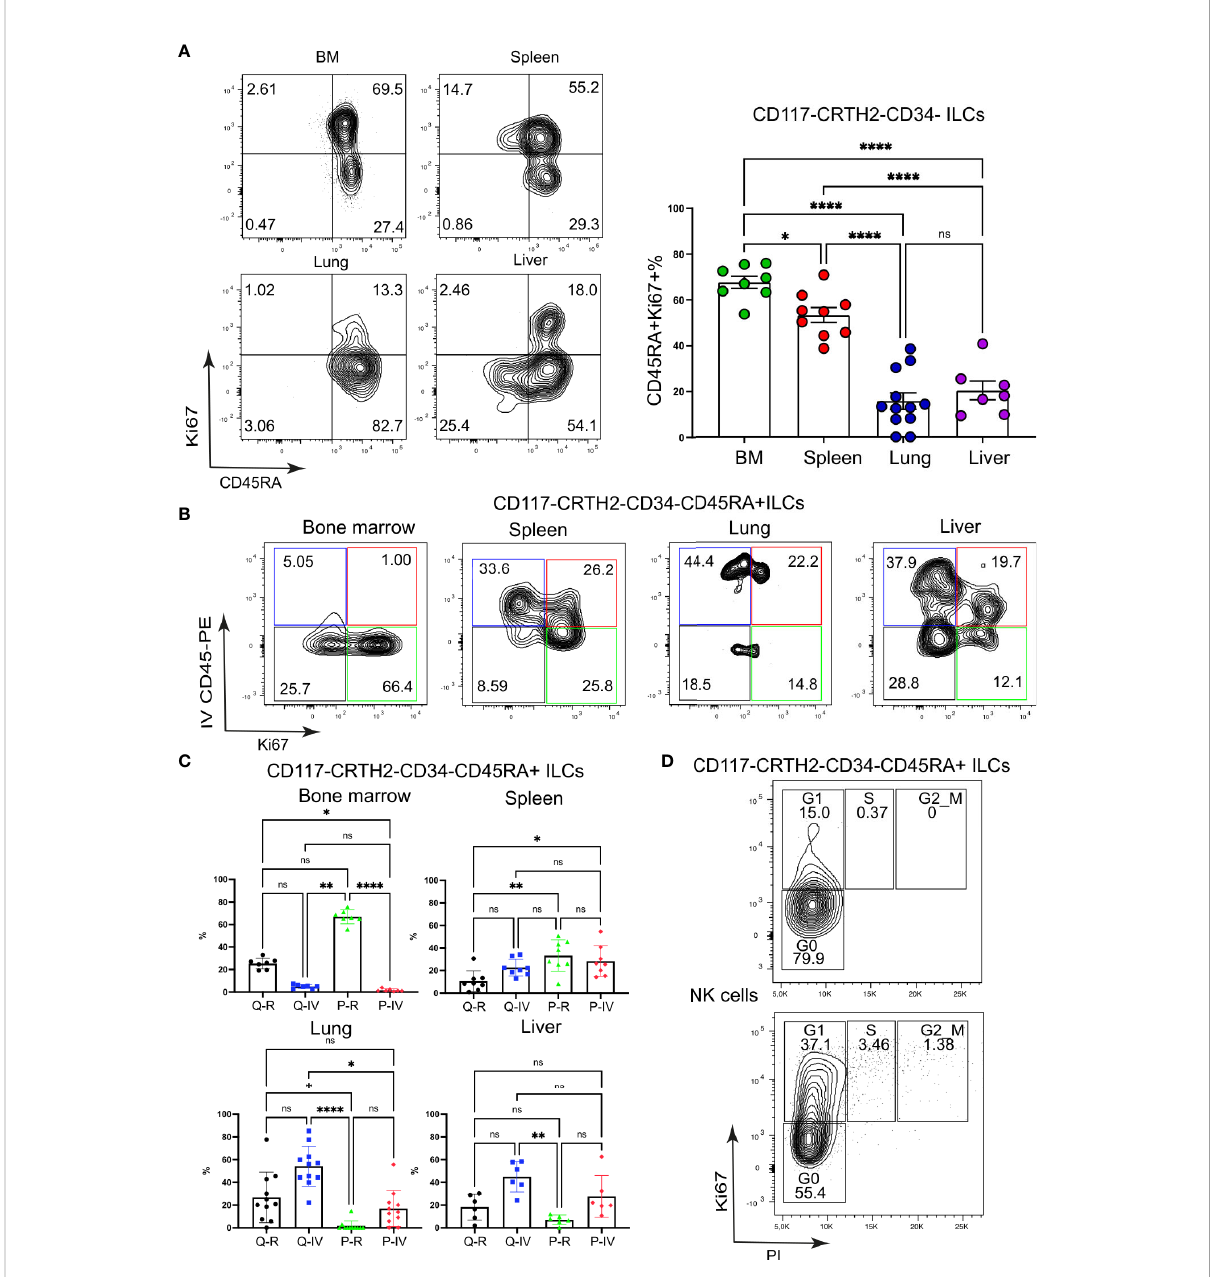
FIGURE 3 CD117 - CRTH2 - CD45RA + ILCs in the spleen are highly proliferative. (A) Frequencies of proliferating CD117 - CRTH2 - CD34 - ILCs according to CD45RA surface expression in various organs of HSPC-engrafted MISTRG mice (n = 7-12). ILCs were gated as human CD45 + CD127 + CD94 - CD3 - TCR ab - Lin - cells as in Supplementary Figure 1 and then gated as CD117 - CRTH2 - CD34 - ILCs. (B) Flow cytometry analysis of intravascular versus extravascular and quiescent versus proliferative CD117 - CRTH2 - CD34 - ILCs in the indicated organs of HSPC-engrafted MISTRG mice. ILCs were gated as human CD45 + CD127 + CD94 - CD3 - TCR ab - Lin - cells as in Supplementary Figure 1 and then gated as CD117 - CRTH2 - CD34 - ILCs. (C) Frequencies of quiescent tissue-resident (Q-R), quiescent intravascular (Q-IV), proliferative tissue-resident (P-R), and proliferative intravascular (P-IV) CD117 - CRTH2 - CD34 - ILCs in the indicated organs (n = 6-11) as determined in (B) . (D) Cell cycle status of CD117 - CRTH2 - CD45RA + ILCs and NK cells from the spleen of HSPC-engrafted MISTRG mice (n = 4). n.s., not signi fi cant; *, P <0.05; **, P < 0.01; ***, P <0.001; ****, P < 0.0001 by one-way ANOVA, Tukey ’ s post-test. Data represent mean ± SEM and are representative of two independent experiments using MISTRG mice engrafted with different pools of HSPCs. (A) was created with Mind the